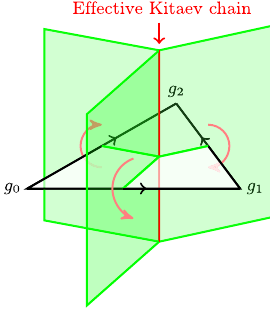
FIG. 15. Decorations of p þ ip chiral superconductors for a triangle h 012 i [see Fig. 8(b) for a tetrahedron]. The 2D chiral superconductors are decorated on the (green) planes dual to the three links h 01 i , h 12 i , and h 02 i . The direction of the chiral Majorana mode along the boundary of the (green) plane dual to link h ij i is indicated by a (red) arc arrow (right-hand rule with respect to the link direction) if n 1 > 0 . So there are three different kinds of chiral Majorana modes along the (red) link dual to the triangle h 012 i . After gapping out these chiral modes symmetri- cally, there may be an effective Kitaev chain along the (red)